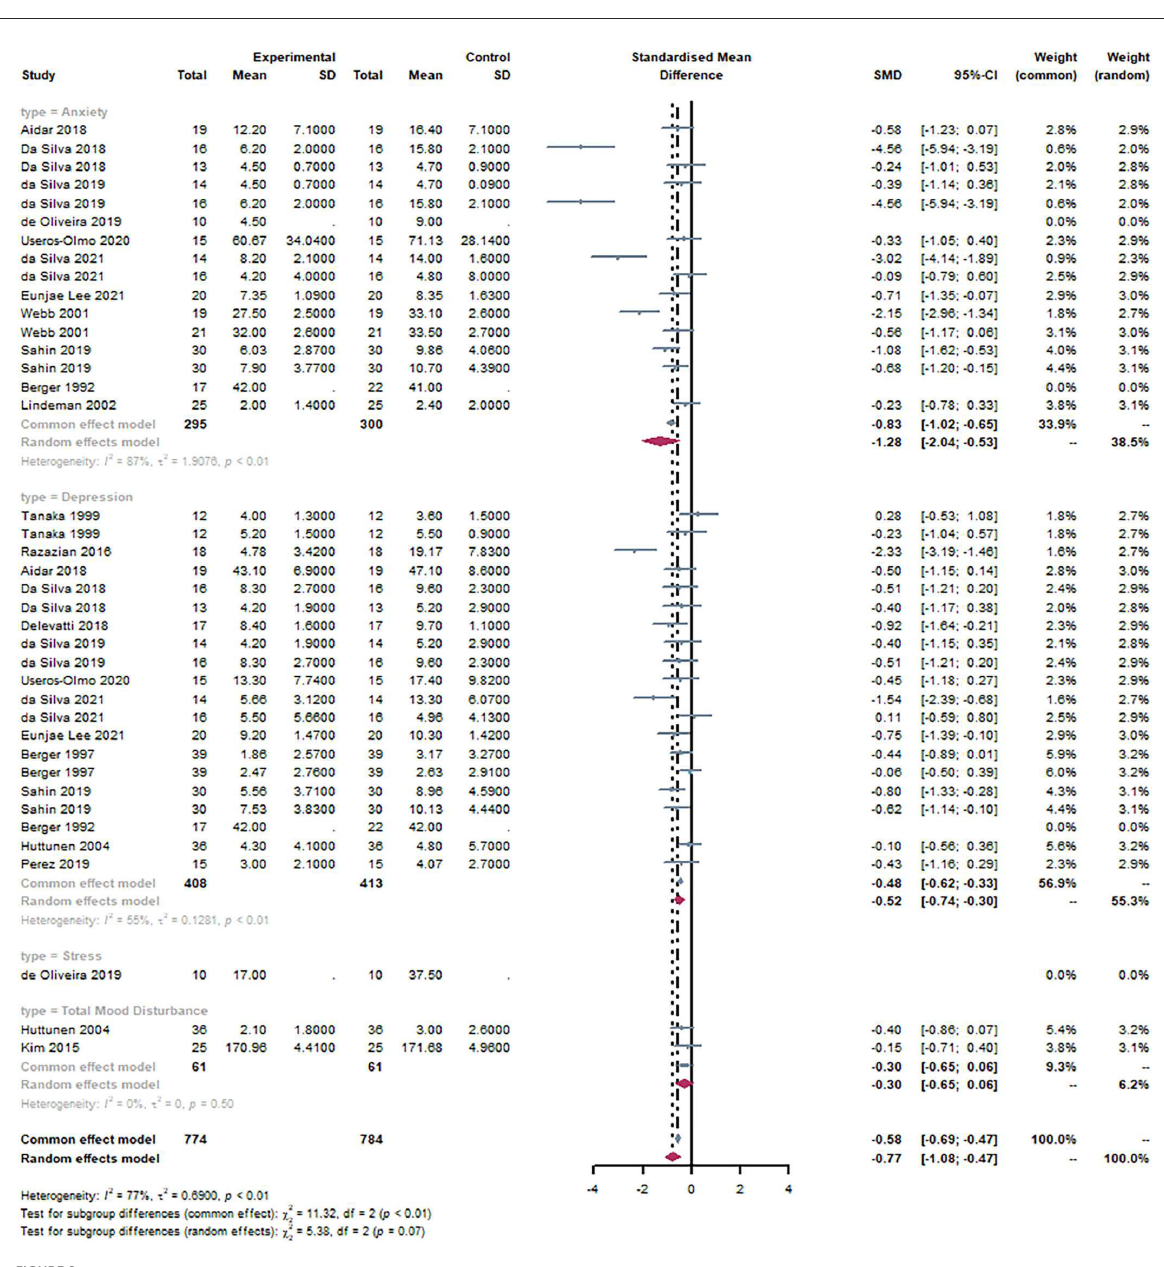
(Figure 10). There was no statistical significance in the high group. There was a statistically significant subgroup effect ( P =